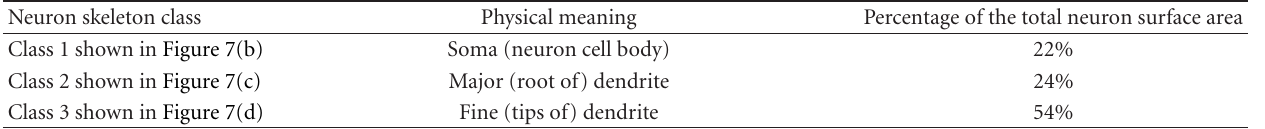
Table 1: Classification of natural neuron